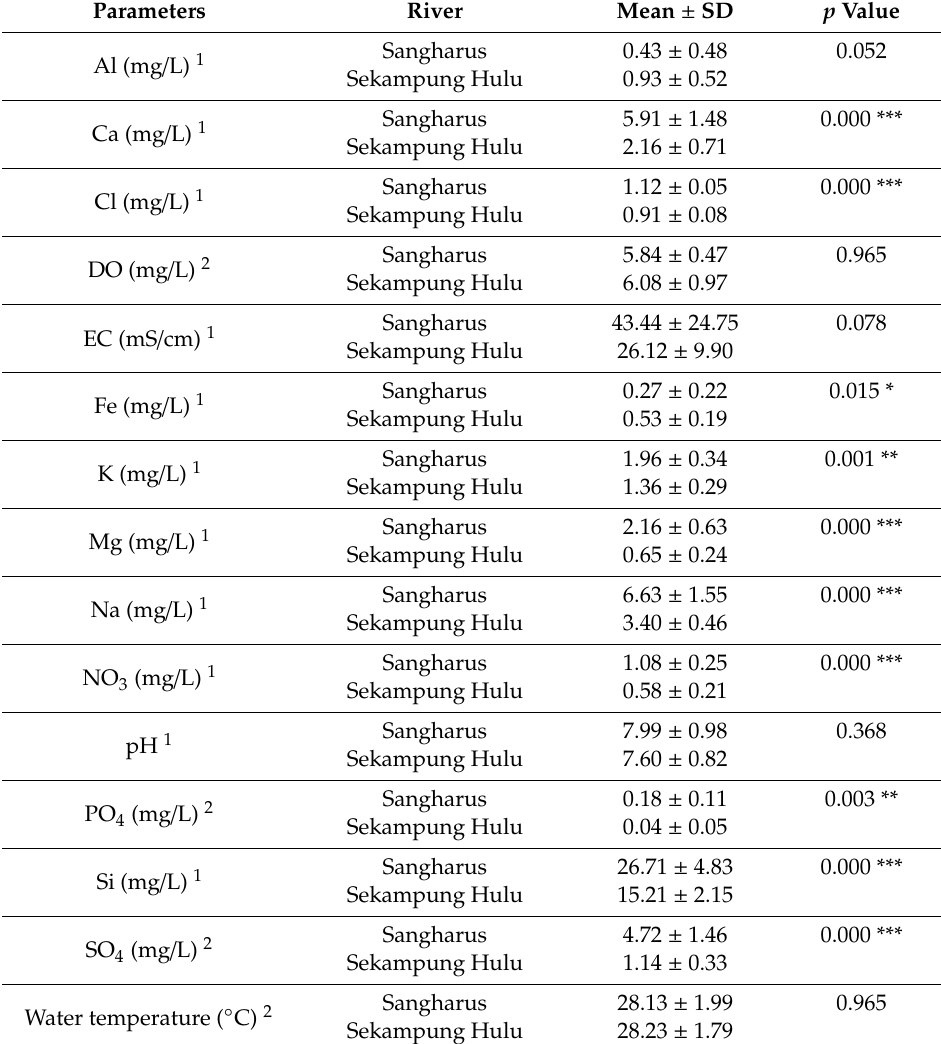
Table 1. Statistical parameters of water quality concentrations in the Sekampung Hulu and Sangharus